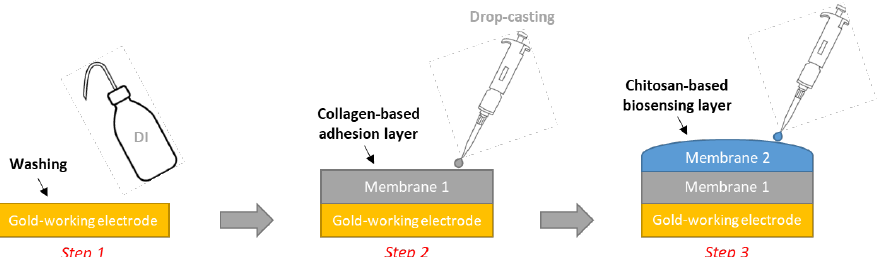
Figure 1. Illustration of the modification process of the working gold-based screen-printed electrode for the fabrication of glucose biosensors. for the fabrication of glucose